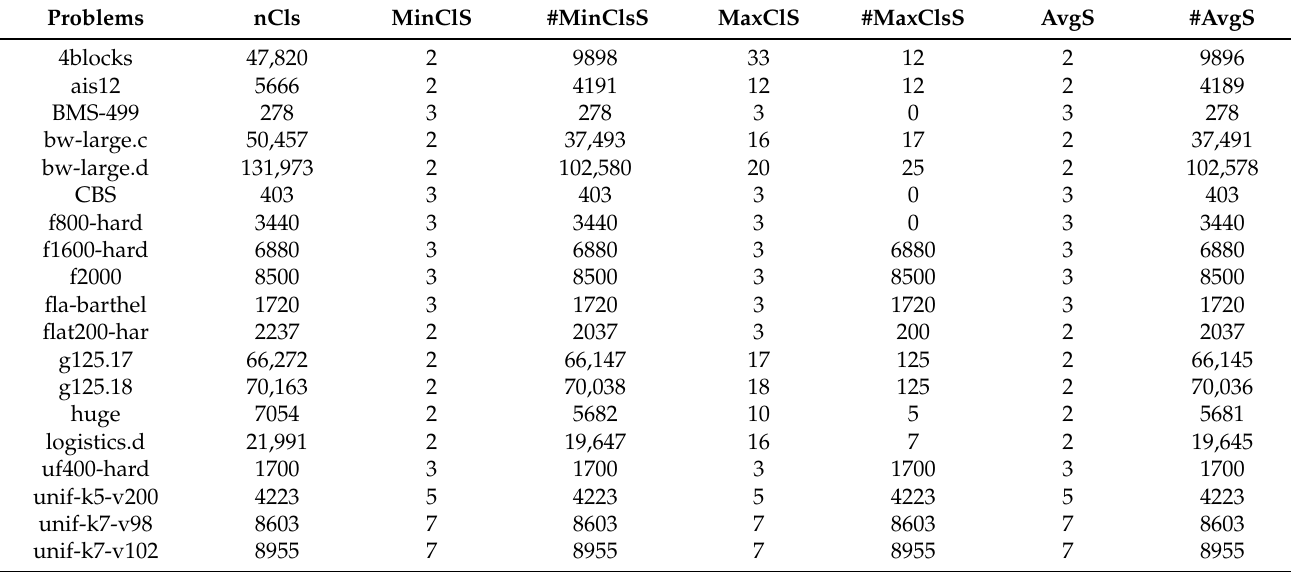
Table 2. Clause specific structural